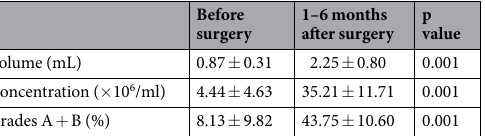
Table 3. Semen analysis results of 19 patients with refractory hematospermia and infertility before and after